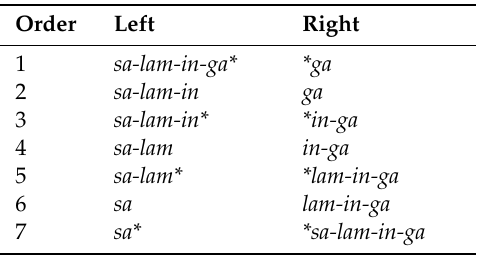
Table 3. The order of the division an eojeol “ sa-lam-in-ga ”.